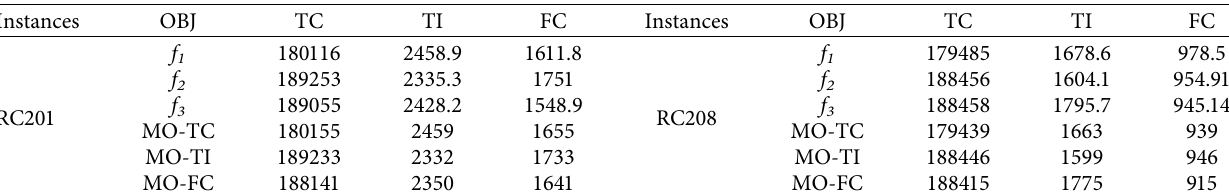
Table 10: The result of the four optimal